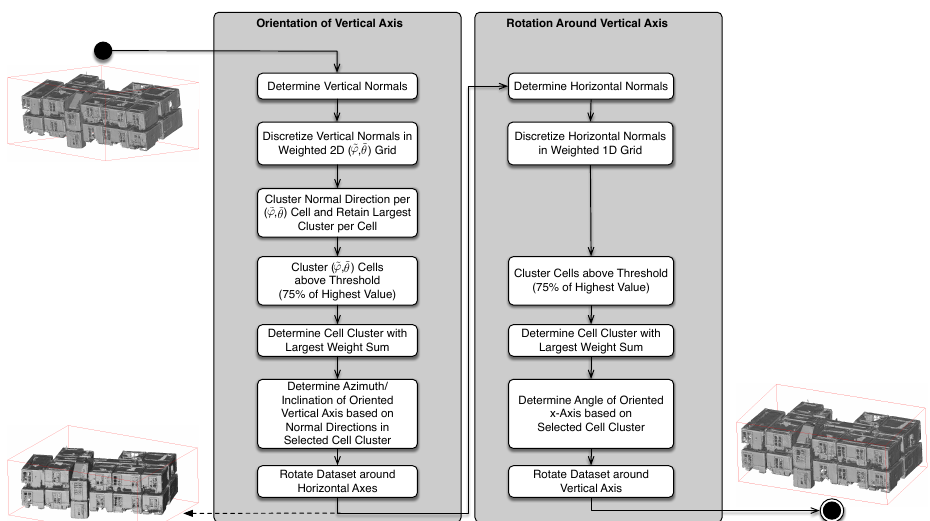
Figure 1. Overview of our pose-normalization method as described in Section 2. The depicted triangle mesh is the dataset “Office” from